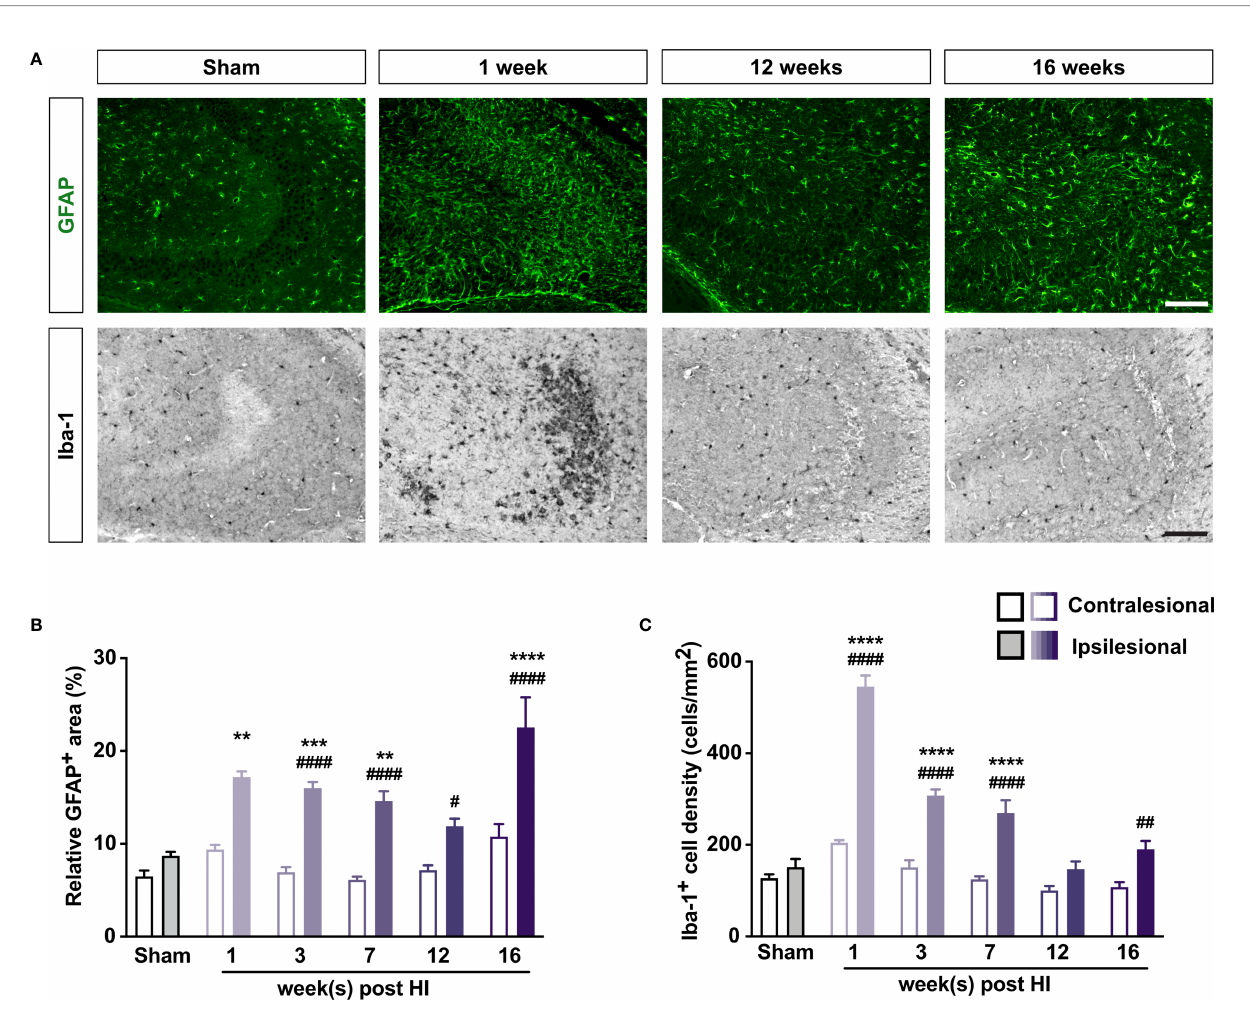
FIGURE 2 | Mild neonatal HI brain injury leads to long-lasting reactive gliosis. (A) Representative images of ipsilesional CA3 immunostained with antibody against GFAP to visualize astrocytes and with antibody against Iba-1 to visualize microglia 1 – 16 weeks after HI induction or 3 weeks after sham surgery. Scale bar = 50 µm. (B) Relative GFAP + area and (C) density of Iba-1 + cells in CA3 of mice 1 – 16 weeks after HI induction or 3 – 7 weeks after sham surgery. IL, ipsilesional; CL, contralesional. ** P < 0.005, *** P < 0.001, **** P < 0.0005 vs sham-operated mice; # P < 0.05, ## P < 0.005, ### P < 0.001, #### P < 0.0005 vs contralesional, by two-way ANOVA and Sidak ’ s posthoc test. n = 8 sham-operated mice; n = 3, 10 – 11, 12 – 13, 9, and 9 mice for 1, 3, 7, 12, and 16 weeks after HI induction, respectively. Values are mean ±